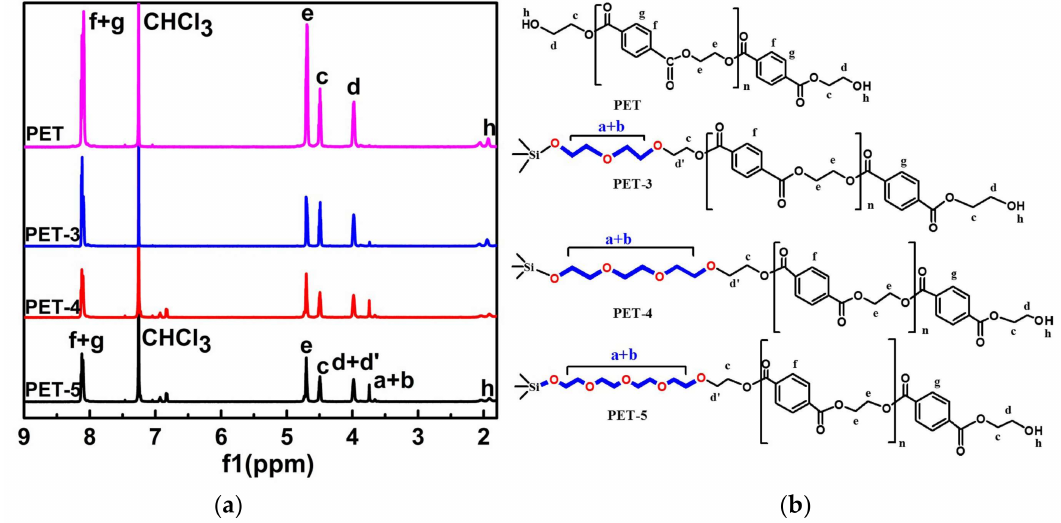
Figure 3. The 1 H-NMR spectra of PET, PET-3, PET-4 and PET-5 ( a ); structural formula with corresponding proton ( b